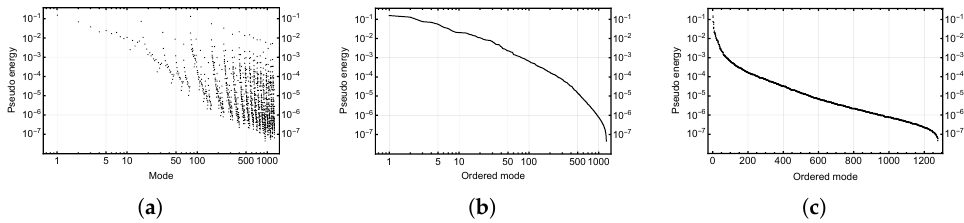
Figure 6. Three regions of uncertain materials. Convergence of the Legendre coefficients in pseudoenergy. In the log-scale plot, the algebraic, exponential, and super exponential regions can be identified. Due to transition phases, accurate determination of respective intervals is difficult. ( a ) Unsorted; observed pseudoenergy per stochastic basis polynomial (loglog). ( b ) Sorted; observed pseudoenergy per stochastic basis polynomial sorted by magnitude (loglog). ( c ) Sorted; observed pseudoenergy per stochastic basis polynomial sorted by magnitude in log-scale.